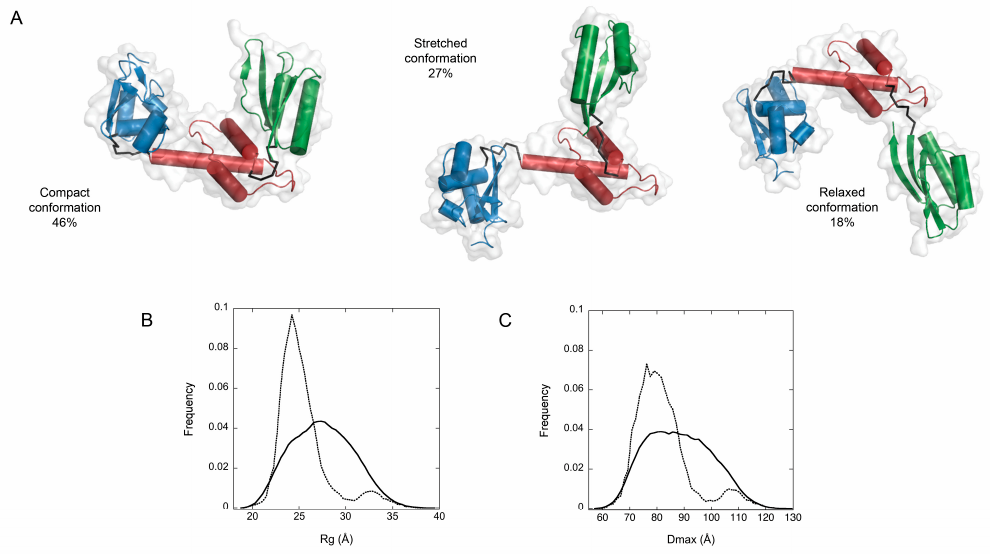
Figure 4. Flexibility analysis of AfSBDS in solution. ( A ) Selected AfSBDS models and their contribution percentage estimated from the final population of EOM models. Domain 1—blue, domain 2—red, domain 3—green. Distribution of radii of gyration ( R g ) ( B ) and intra-atomic distance maxima ( D max ) ( C ) in the initial pool of random AfSBDS structures (solid trace) overlapped to that of the final conformational sub-ensemble (dotted trace).